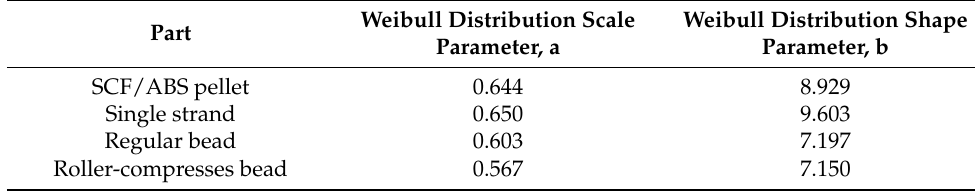
Table 6. Weibull distribution parameters of void sphericity in four scanned parts.